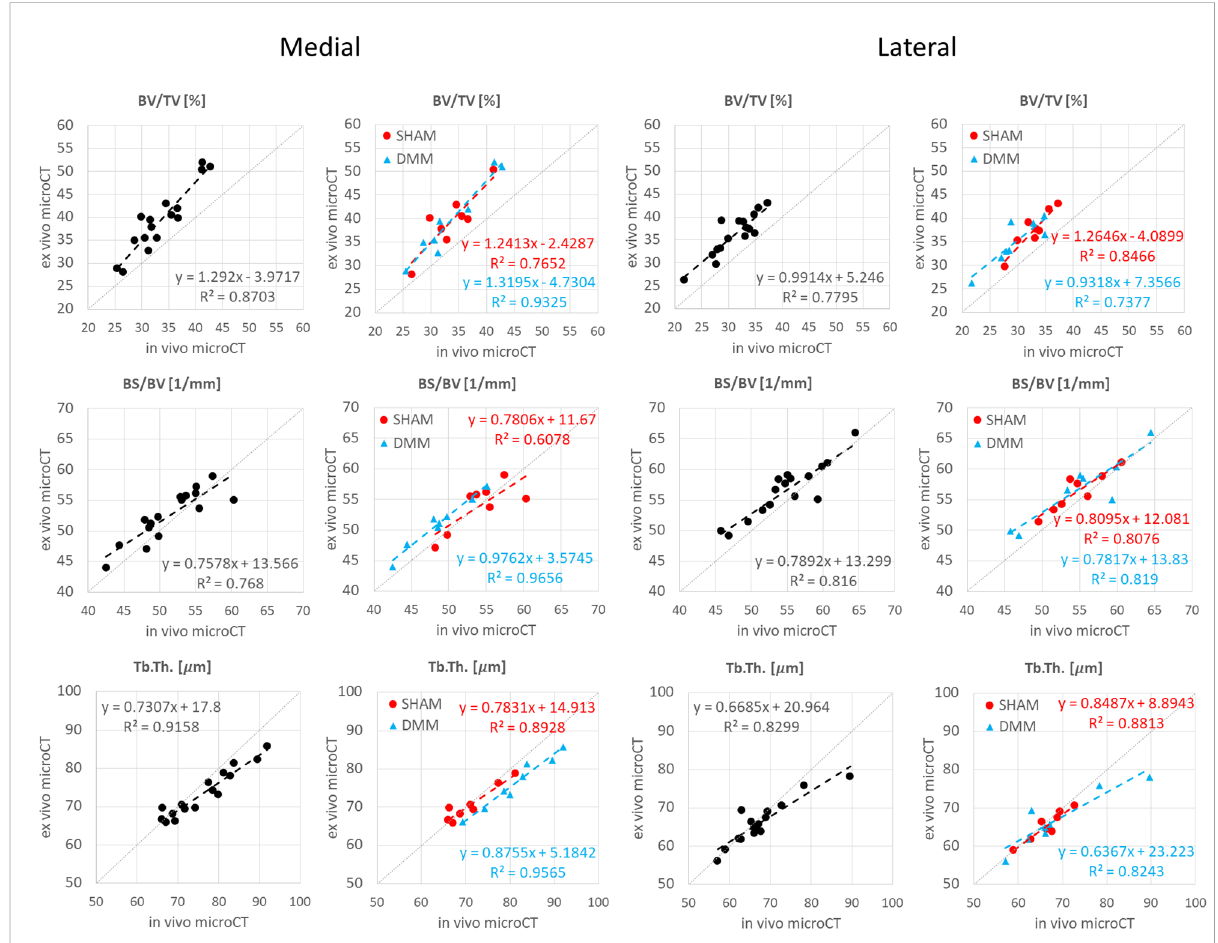
FIGURE A1 Regression analyses between in vivo and ex vivo measurements for bone volume fraction (BV/TV), bone surface fraction (BS/BV) and trabecular thickness (Tb.Th) in the medial and lateral